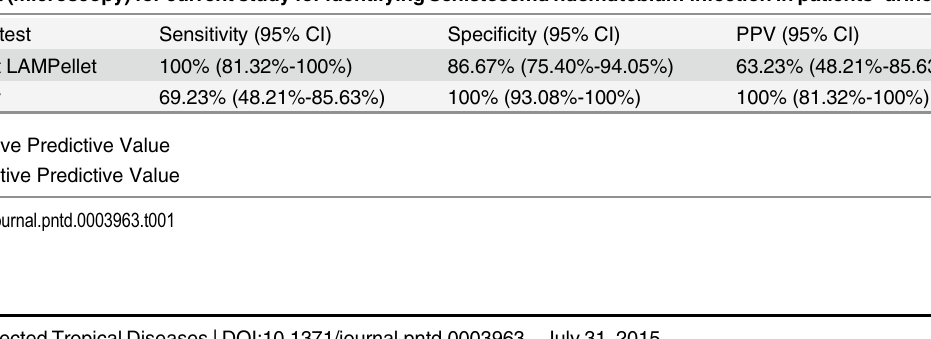
Table 1. Estimation of sensitivity, specificity, predictive values and likelihood ratios by Rapid-Heat LAMPellet method against standard parasito- logical test (microscopy) for current study for identifying Schistosoma haematobium infection in patients´ urine